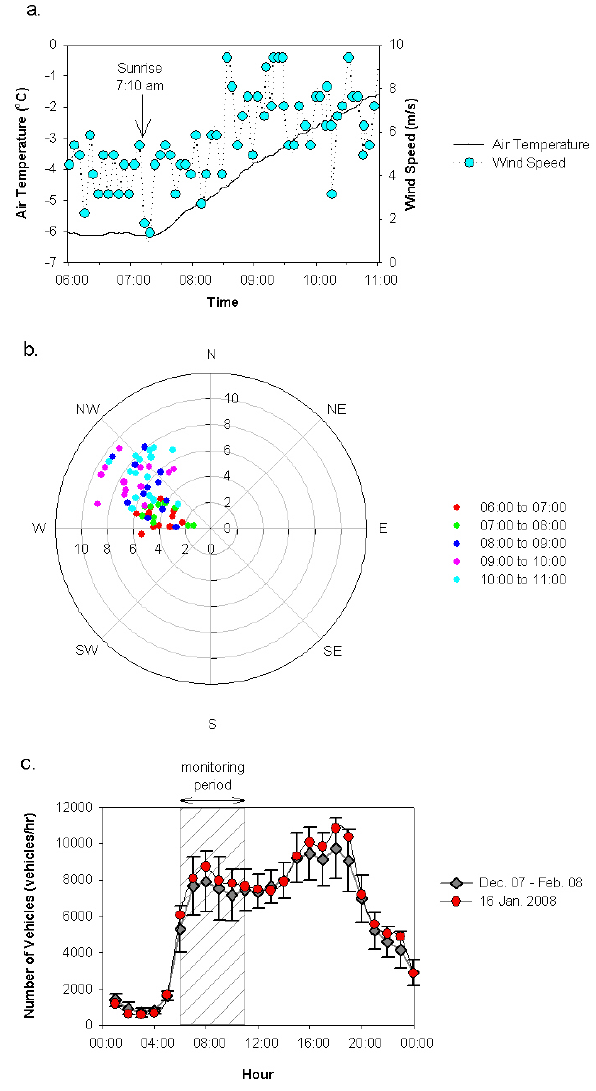
Fig. 2. Weather and traffic data from 16 January 2008. (a) Time- series of air temperature and wind speed; (b) 5-min average of wind speed and wind direction data collected between 06:00 and 11:00 at the Hormel Stadium light tower in Medford, ∼ 0.5km from moni- toring area; (c) time-series of traffic flow on I-93 in both the north and south lanes measured at Somerville-Medford line. Weekday hourly average traffic volume ( ± one SD) on I-93 during the winter of 2008 are also